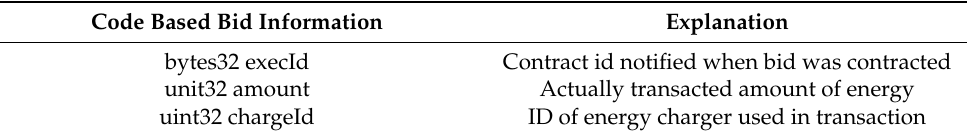
Table 3. Energy Transaction Execution Report